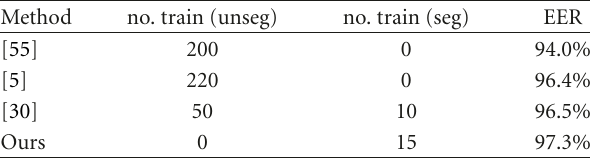
Table 2: Composition of training set and EER for face test